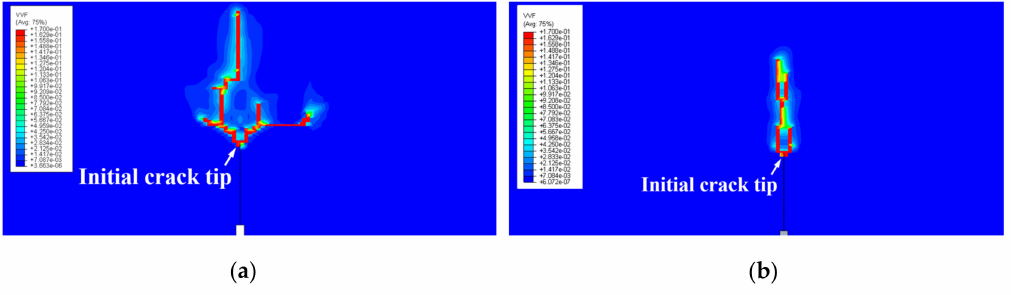
Figure 12. The typical crack propagation paths when the widths of the center region were 20 mm ( a ) and 50 mm ( b